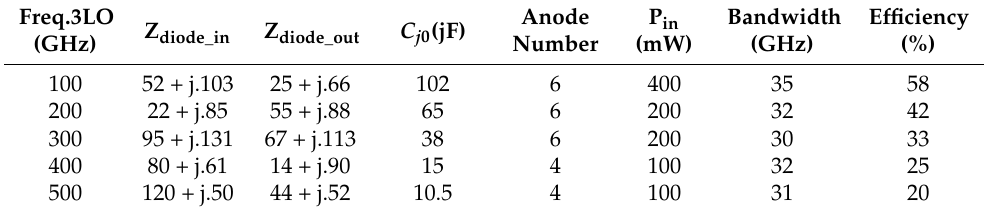
Table 1. Circuit model results.